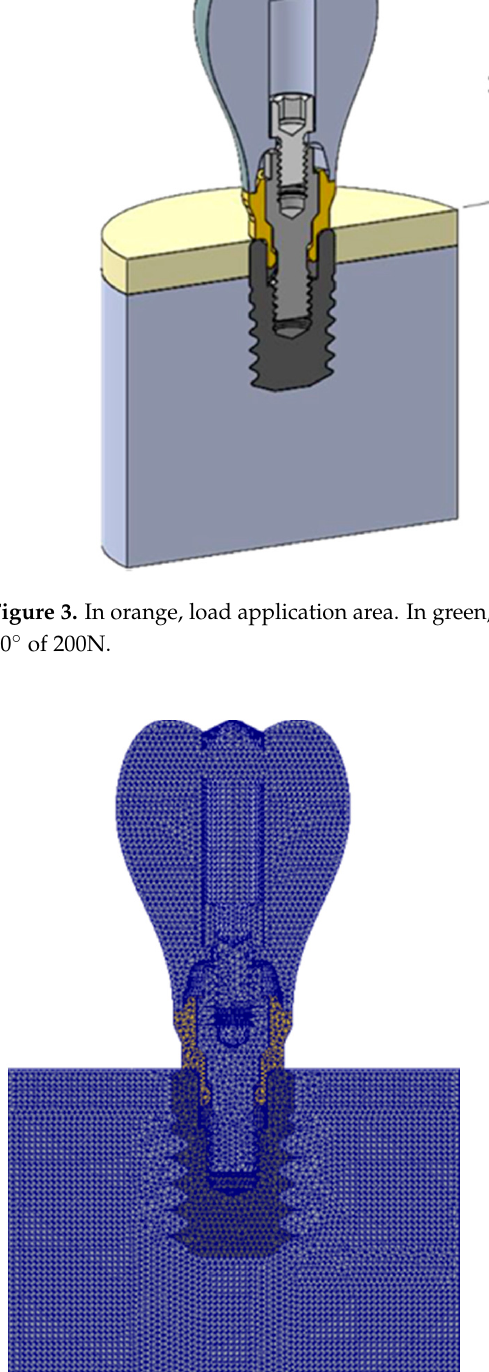
Figure 4. Finite element model mesh.